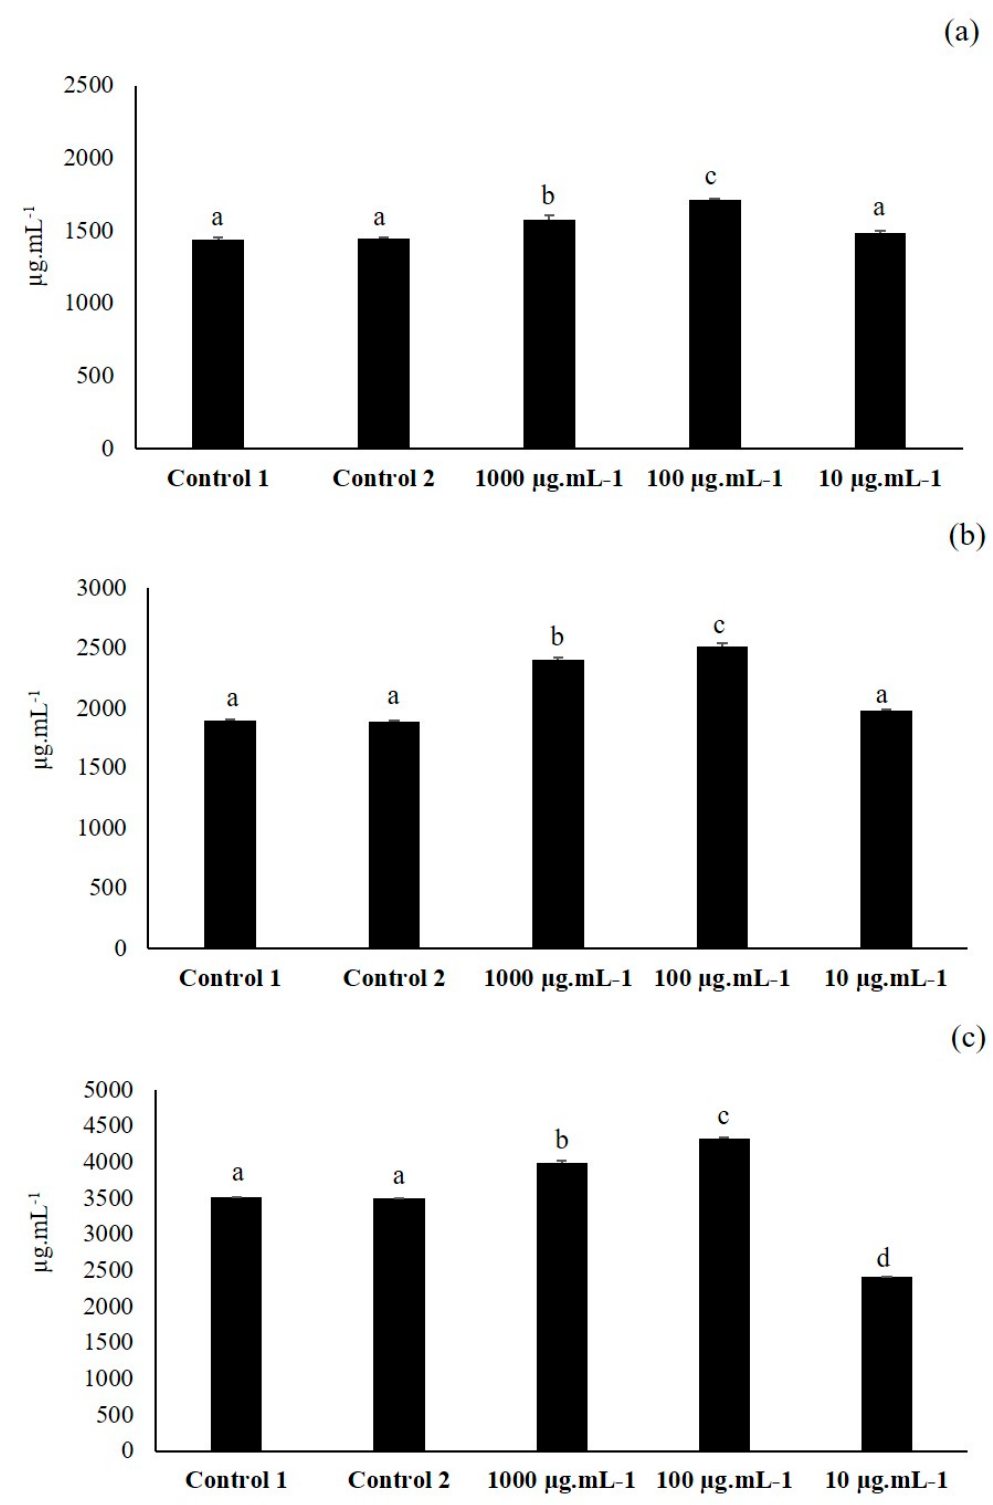
Figure 2. Daidzin ( a ), genistin ( b ) and malonyl genistin ( c ) production in the seeds inoculated with the extract obtained from the metabolic elicitors at 1000, 100 and 10 µ g · mL − 1 and in control 1 (extract obtained from the liquid–liquid phase separation from the culture broth without bacteria) and control 2 (non-inoculated soybean seeds). The amount of isoflavones is expressed in µ g · mL − 1 ( n = 30 soybean seeds × 3 replicates). Di ff erent letters show significant statistical di ff erences between treatments in each isoflavone ( p < 0.05). Error bars correspond to standard deviation